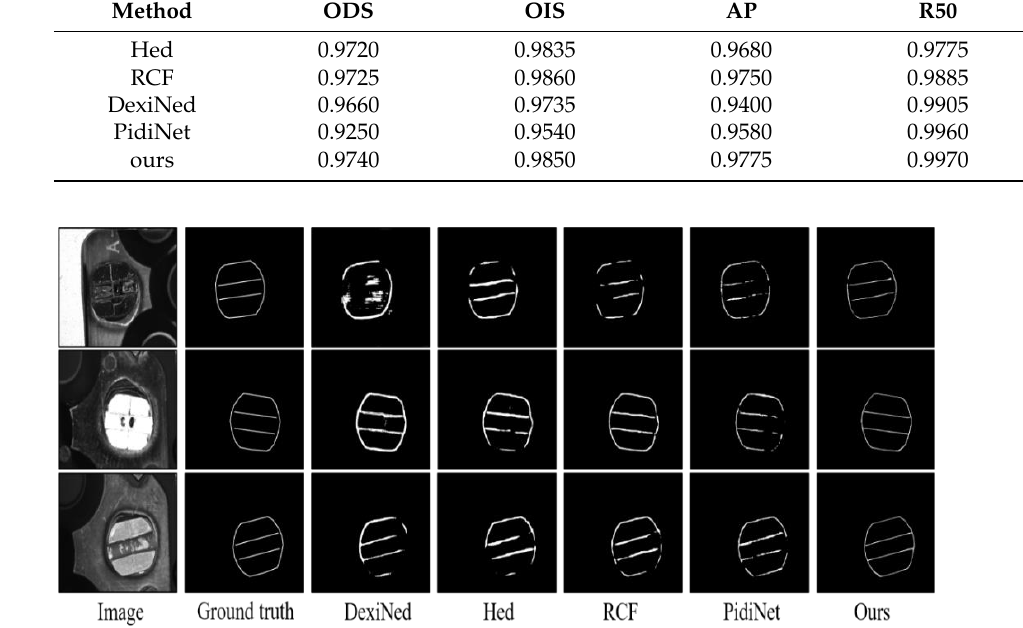
Table 3. Accuracy and error values of different methods.